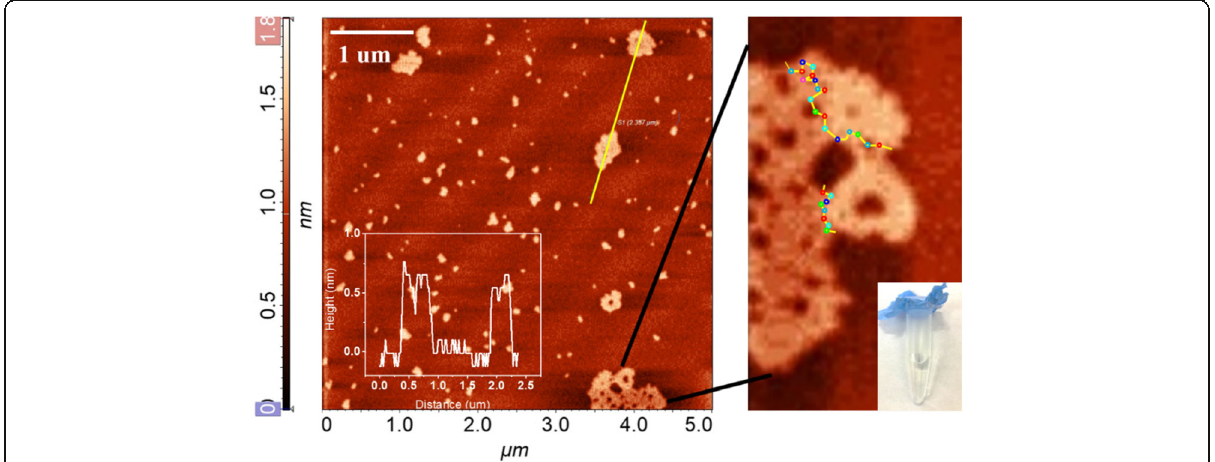
Fig. 7 AFM of monolayer nano-graphene under excess UV exposure, inset: digital photos of aggregated